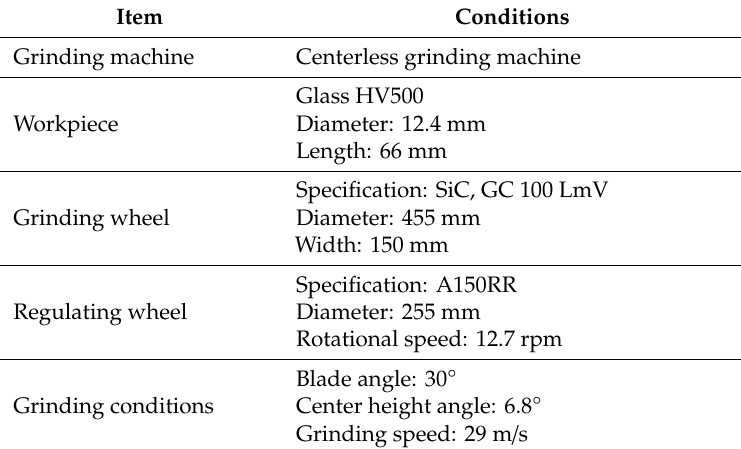
Table 7. Grinding conditions of plunge centerless grinding.